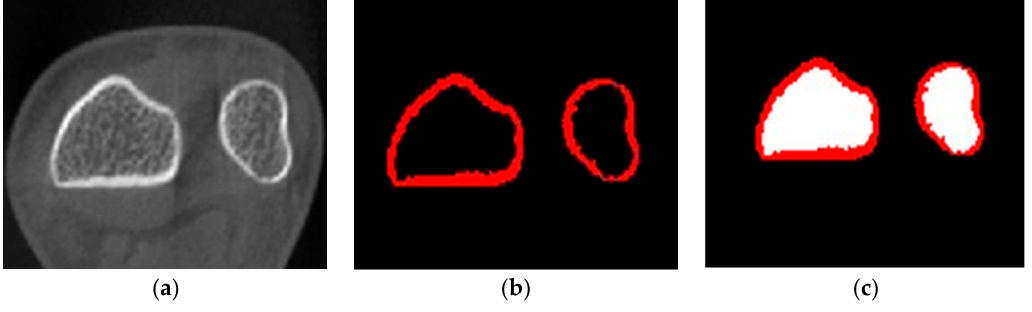
Figure 1. ( a ) Forearm images of the radius and ulna. ( b ) Separation of the cortical bones. ( c ) Total bone areas (red area + white area). areas (red area + white